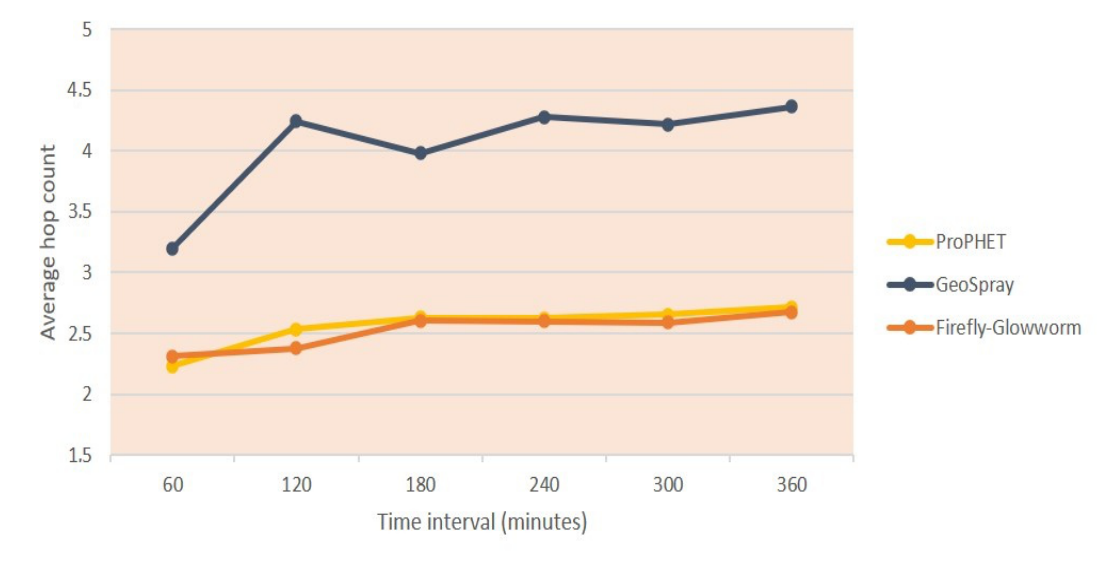
Figure 9. Average hop